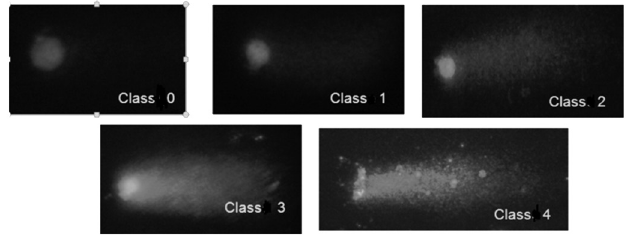
FIGURE 2 Photomicrographs of human lymphocyte nucleoid stained with propidium iodide. 200x